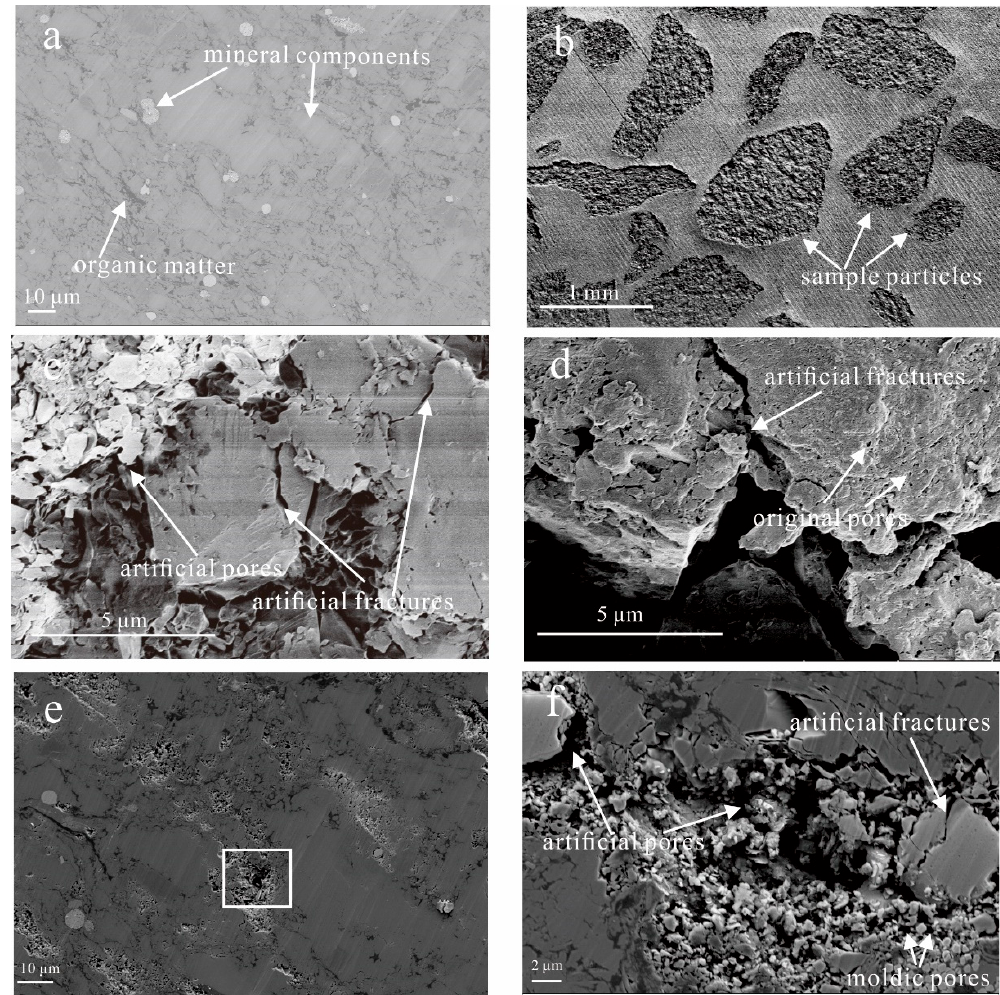
Figure 9. Field emission-scanning electron microscopy (FE-SEM) images of the TY1-20 sample. ( a ) Smooth surface of shale obtained by argon-ion-beam polishing; ( b ) Crushed subsamples were then fixed with epoxy resin; ( c ) Artificial pores and microcracks; ( d ) Artificial microfractures perpendicular to the bedding direction; ( e ) Marks of the crushing process on the smooth surface; ( f ) An enlargement of the crush mark in the rectangle area in Figure 9e.